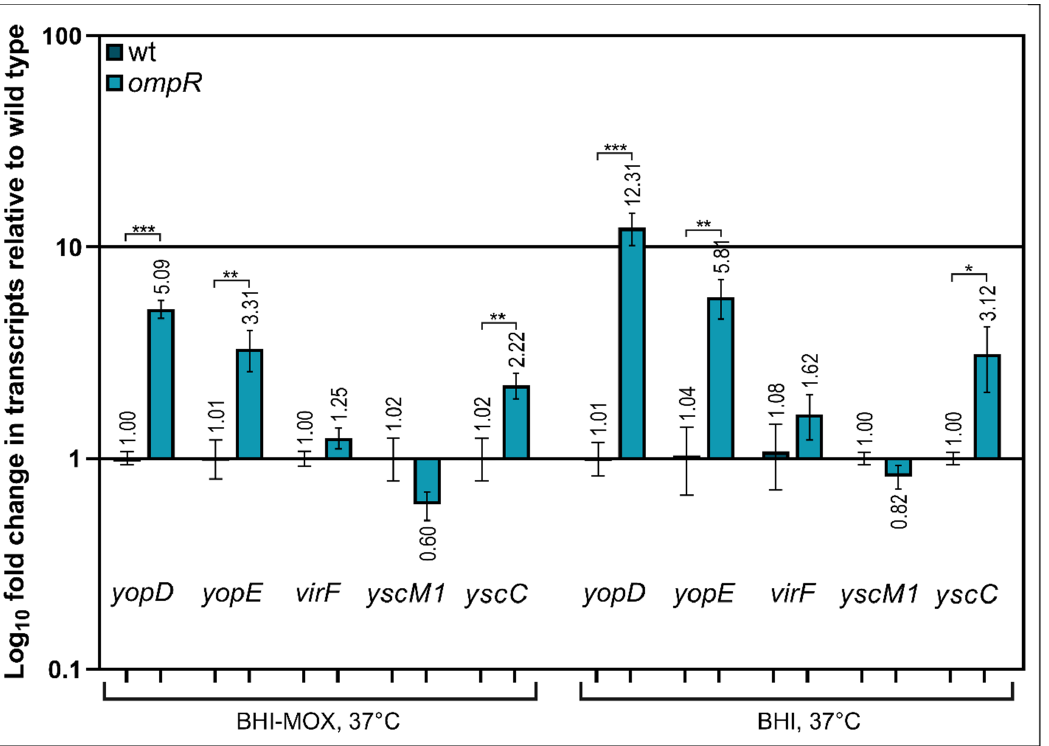
Figure 5. Effect of the ompR mutation on the expression of Ysc-Yop T3SS genes. Levels of the mRNAs encoding T3SS-related proteins in the wild-type strain Ye9 and the ompR mutant strain AR4 were evaluated by RT-qPCR: regulators VirF and YscM1, effector protein YopE, translocator protein YopD and secretin YscC. Relative yopD , yopE , virF , yscM1 and yscC transcript levels were normalized to the amount of 16S rRNA, taking the mRNA level in Ye9 as 1. Values presented are the mean ± standard deviation from three independent experiments. Significance was determined using Student’s t -test (* indicates significance at p < 0.05; ** at p < 0.01; *** at p <